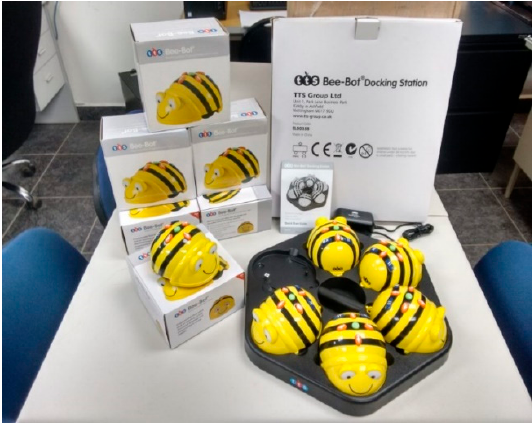
Figure 1. Kit for the development of the